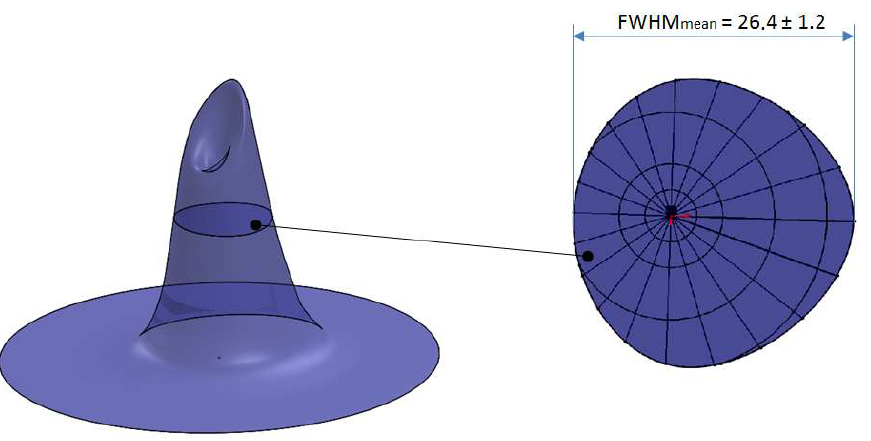
Figure 10. 3-D mapping of SQM 5009 angular response ( left ), based on its two orthogonal angular response curves and average FWHM ( right ).